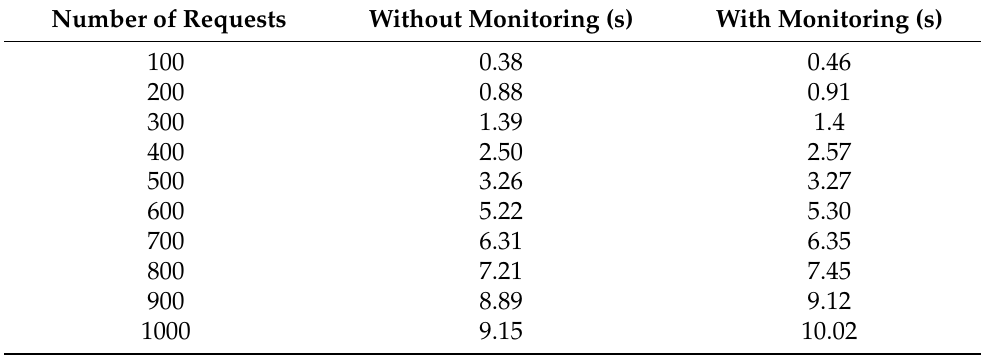
Table 7. Overhead of the monitoring